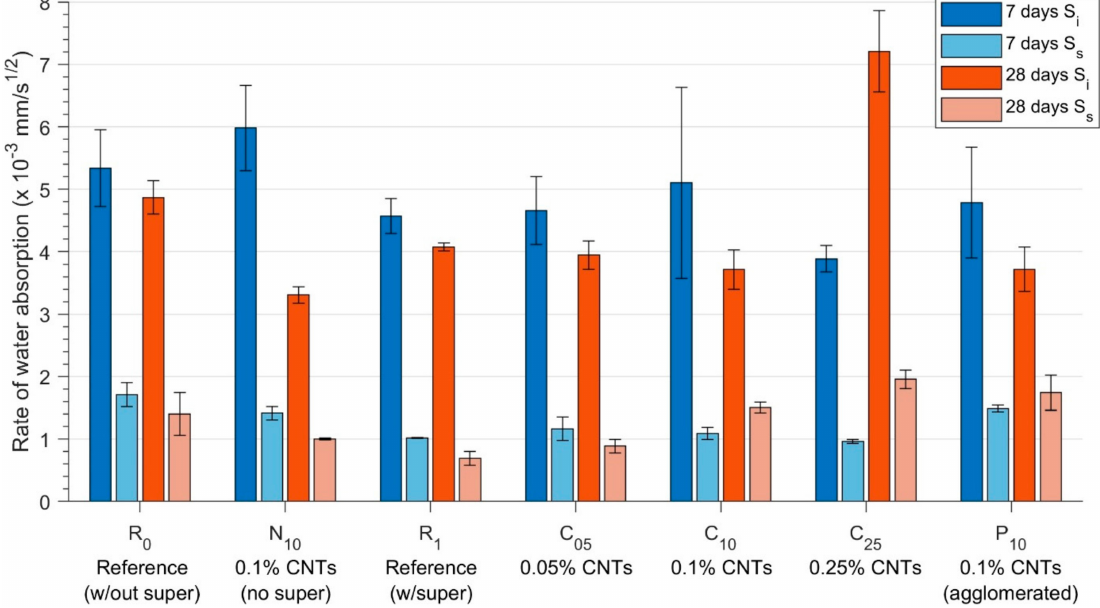
Figure 6. Calculated coe ffi cients of initial (S i ) and secondary (S s ) water absorption (sorptivity, mm / s 1 / 2 ) for specimens at 7 days and 28 days. Error bars show ± 1 standard deviation of